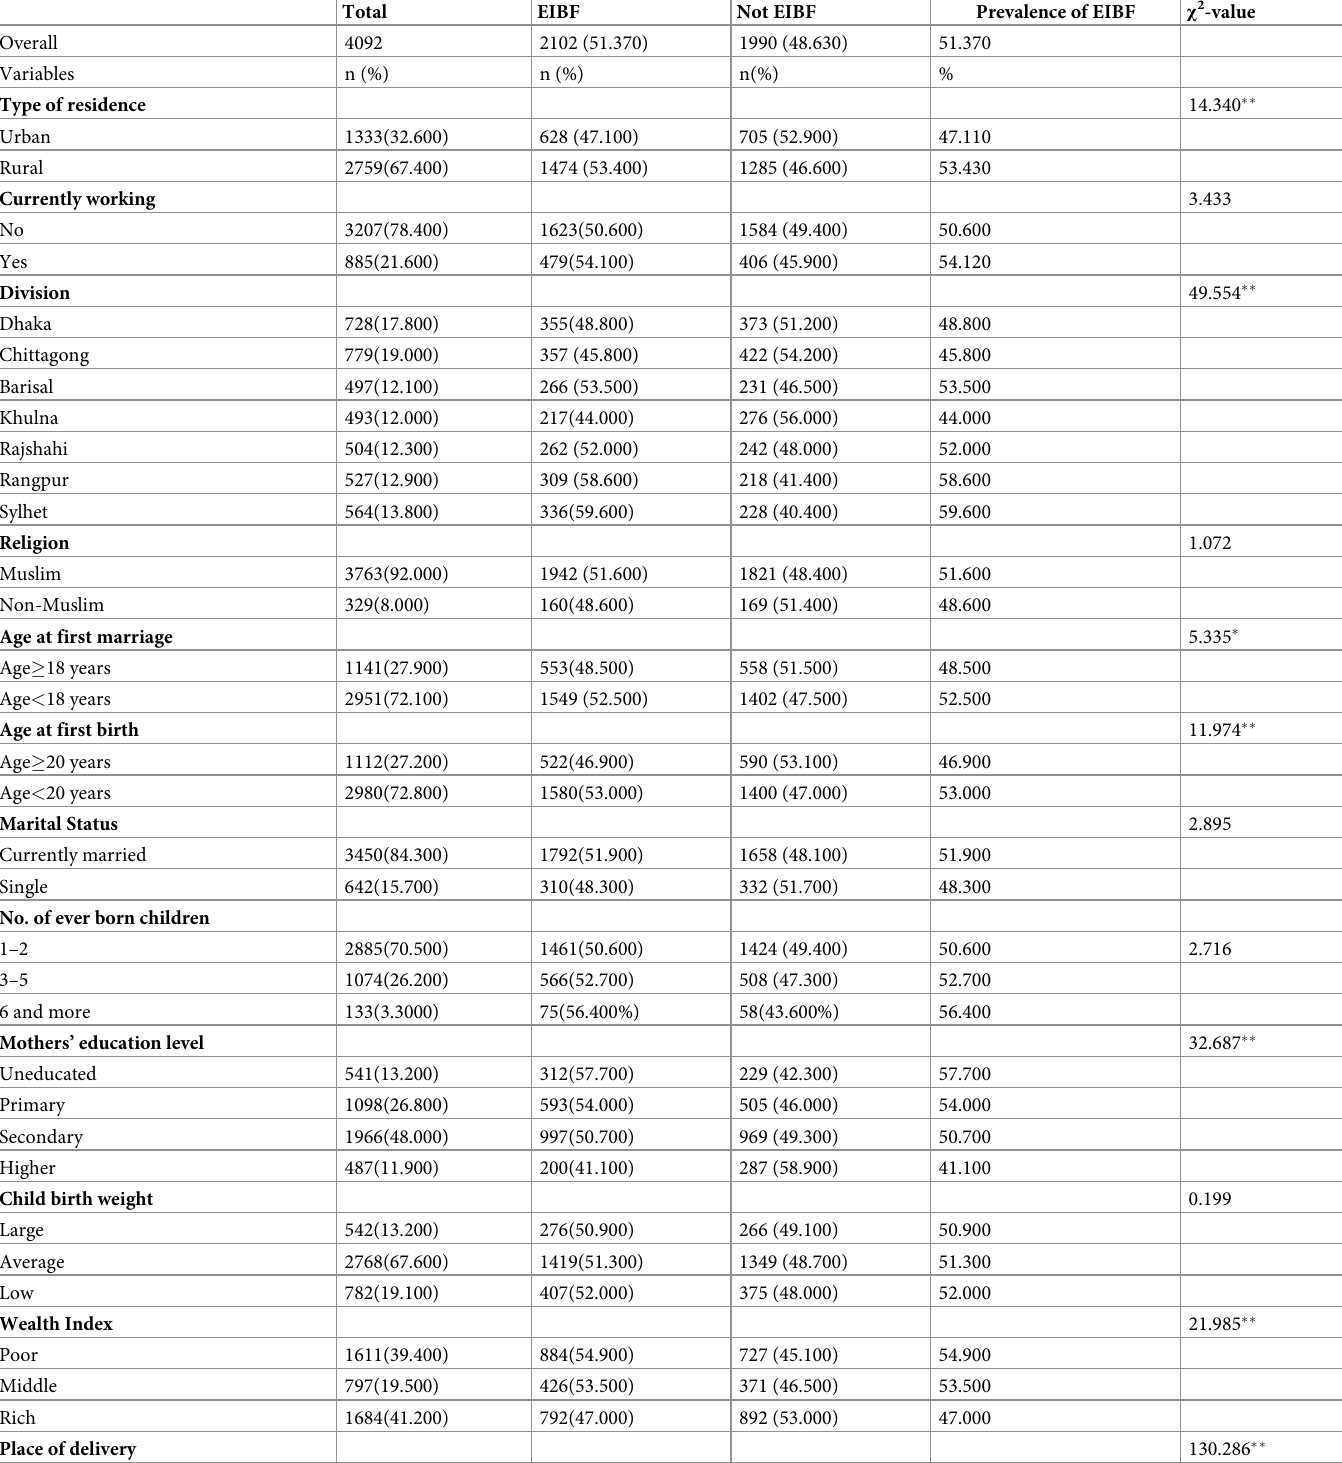
Table 1. Characteristics of the study participants by: 1) Early initiation of breastfeeding and 2) Prevalence of early initiation of breastfeeding. Bangladesh Demo- graphic and Health Survey (BDHS), 2014 (N =